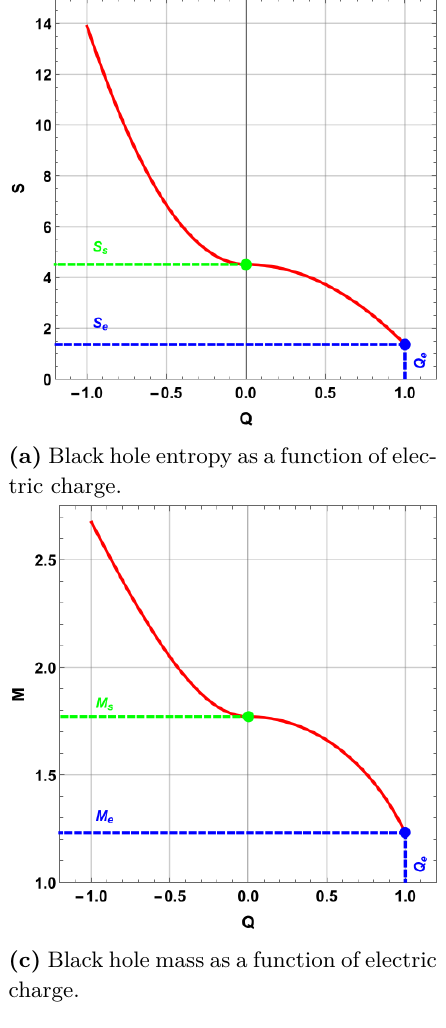
Figure 10. Evolution of different thermodynamical variables during an absorption of 10 3 particles with a fixed electric charge dQ = − 0 . 002 . The initial conditions are Q = 1 , l = 1 , M = 1 . 23 , r h = 0 . 65 and D = 4